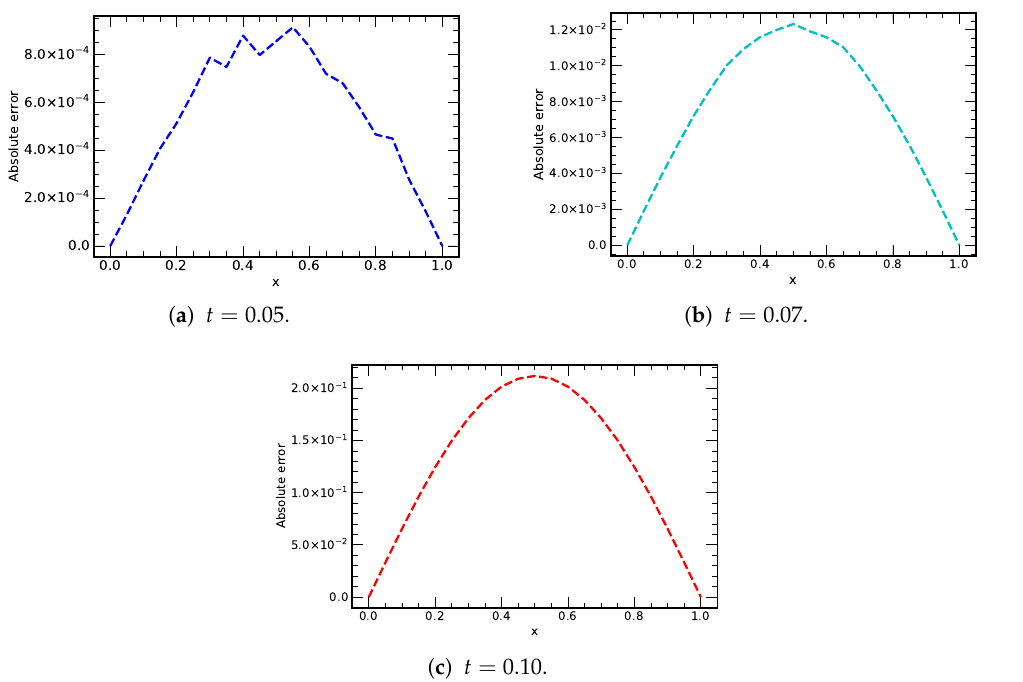
Figure 5. Plots of absolute errors vs. x using 7-terms of LADM at different values of time ( t =